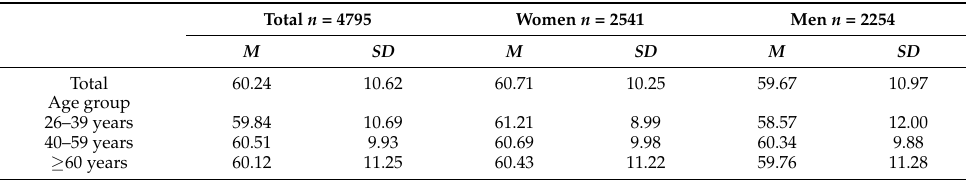
Table 2. Mean resilience by age group and gender.